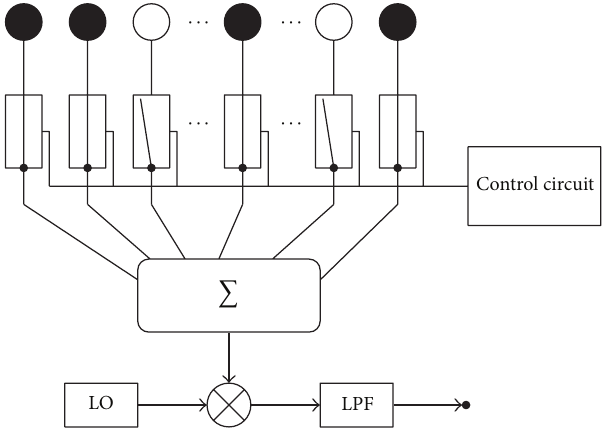
Figure 1: An illustration of a TM array receiver